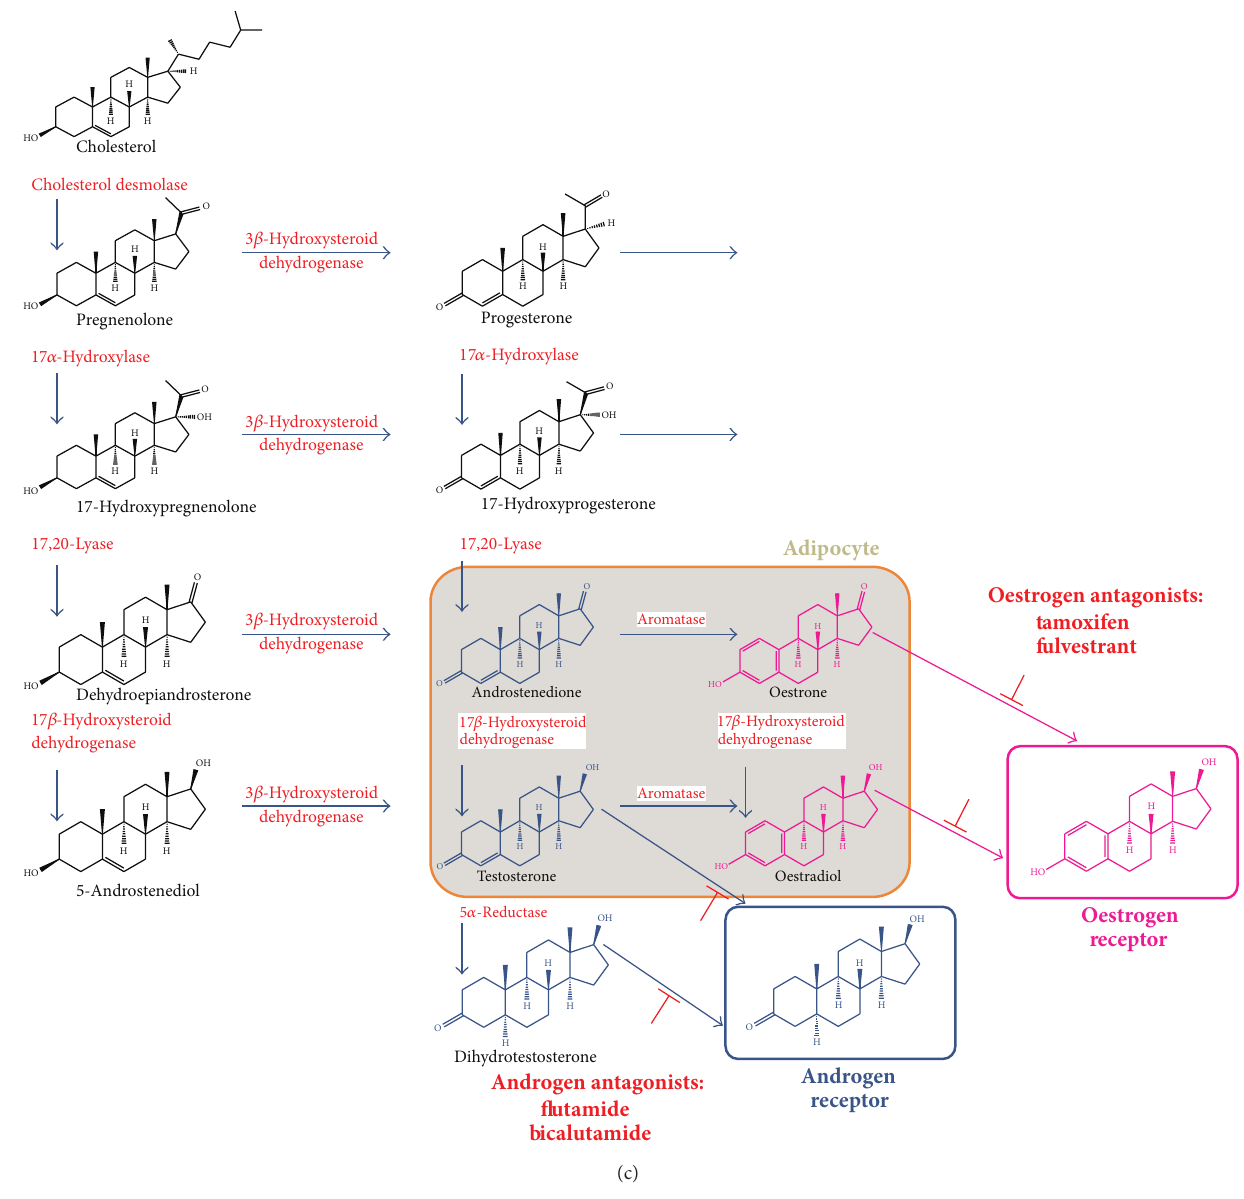
Figure 4: Steroid hormone biosynthesis and therapeutic prevention of steroid hormone action . The sterol cholesterol which contains 27 carbons and includes four interconnected cyclic hydrocarbons is the precursor of all steroid hormones (a). Removal of the cholesterol side chain yields the 21-carbon pregnenolone which is metabolised further to give active progestogens which are in turn converted into glucocorticoids and mineralocorticoids (not shown). Pregnenolone and progesterone may be converted also to 17 𝛼 -hydroxy pregnenolone and 17 𝛼 -hydroxy progesterone which are the precursors of the 19-carbon androgens. Metabolism of androgens by aromatisation of the first cyclic hydrocarbon and removal of carbon 19 produces the 18-carbon oestrogens. Two important enzymes in the end stages of androgen and oestrogen synthesis are expressed in adipocytes: 17 𝛽 -hydrosteroid dehydrogenase converts androstenedione into the much more potent testosterone and oestrone into the more potent oestradiol. Aromatase converts the androgens androstenedione and testosterone into oestrone and oestradiol, respectively. All steroid hormones interact with and activate a cognate receptor which is a ligand-dependent transcription factor. For instance, all active androgens interact with the androgen receptor and all oestrogens interact with an oestrogen receptor. Systemic therapeutic intervention to inhibit androgen or oestrogen action involves inhibition of enzymes involved in their synthesis (b) or competitive inhibition of the interaction of the steroid ligands with their receptors (c). Recently, 17 𝛼 -hydroxylase inhibitors such as abiraterone and orteronel have been developed and are in clinical trial for the treatment of antiandrogen refractory prostate cancer. Inhibitors of 5 𝛼 reductase such as finasteride and dutasteride are used in the treatment of benign prostatic hyperplasia and male pattern baldness. Aromatase inhibitors such as type I inhibitor anastrozole and type II steroid inhibitor exemestane are used widely in the treatment of postmenopausal women with breast cancer. Oestrogen antagonists include the partial antagonist tamoxifen which is a triphenylethylene derivative and the pure antioestrogen fulvestrant which is a steroid. Androgen antagonists include the nonsteroidal pure antiandrogens flutamide and bicalutamide which is the mainstay of systemic therapy in prostate cancer